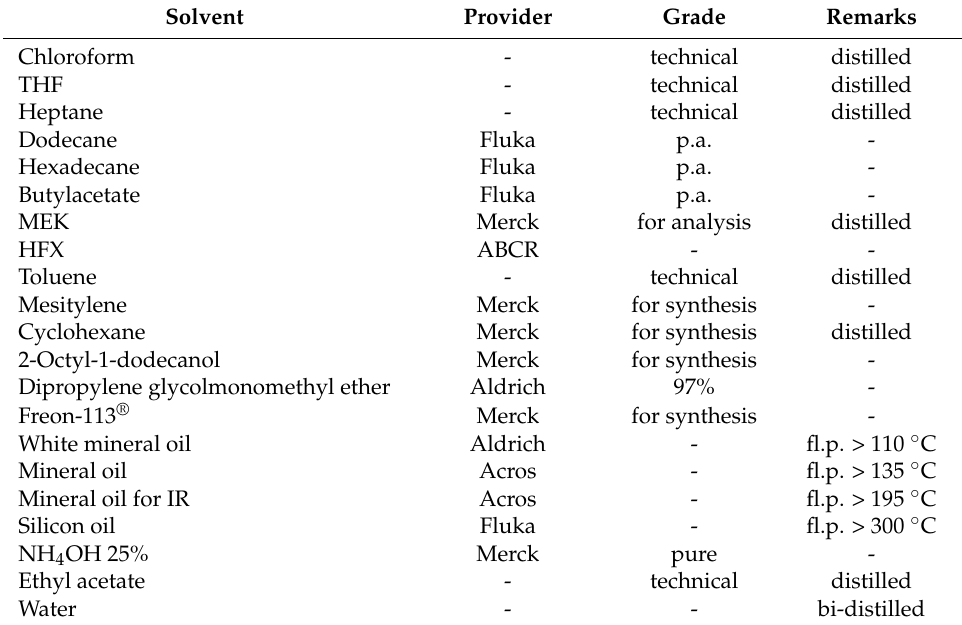
Table 2. Solvents used for solubility and emulsifying